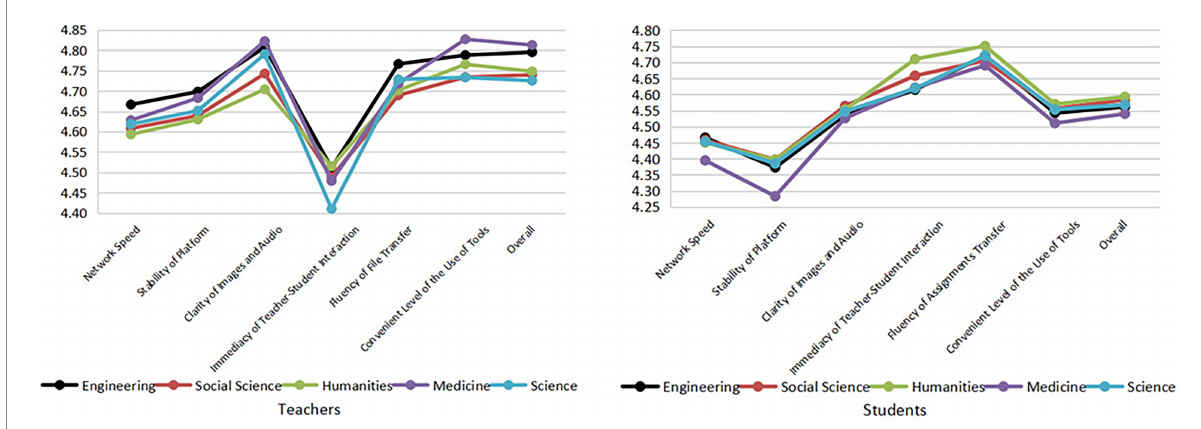
FIGURE 6 The evaluation of teaching platform technology support by teachers and students of different